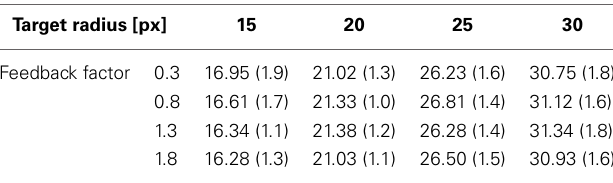
Table 3 | Mean judgments of target radius as a function of target size and of feedback